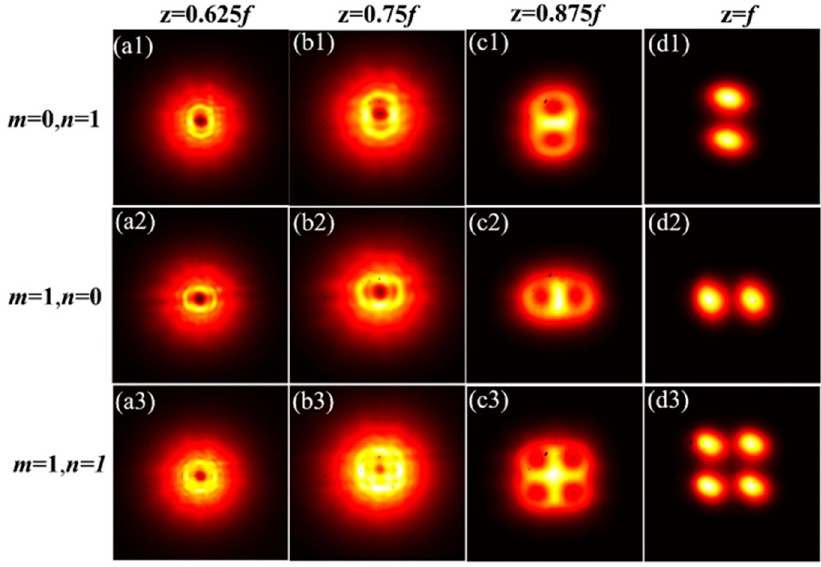
Figure 10. Experimental result of the intensity of a focused HGCSMLG 0l beam at different distances for different beam orders m , n with 2 l = .